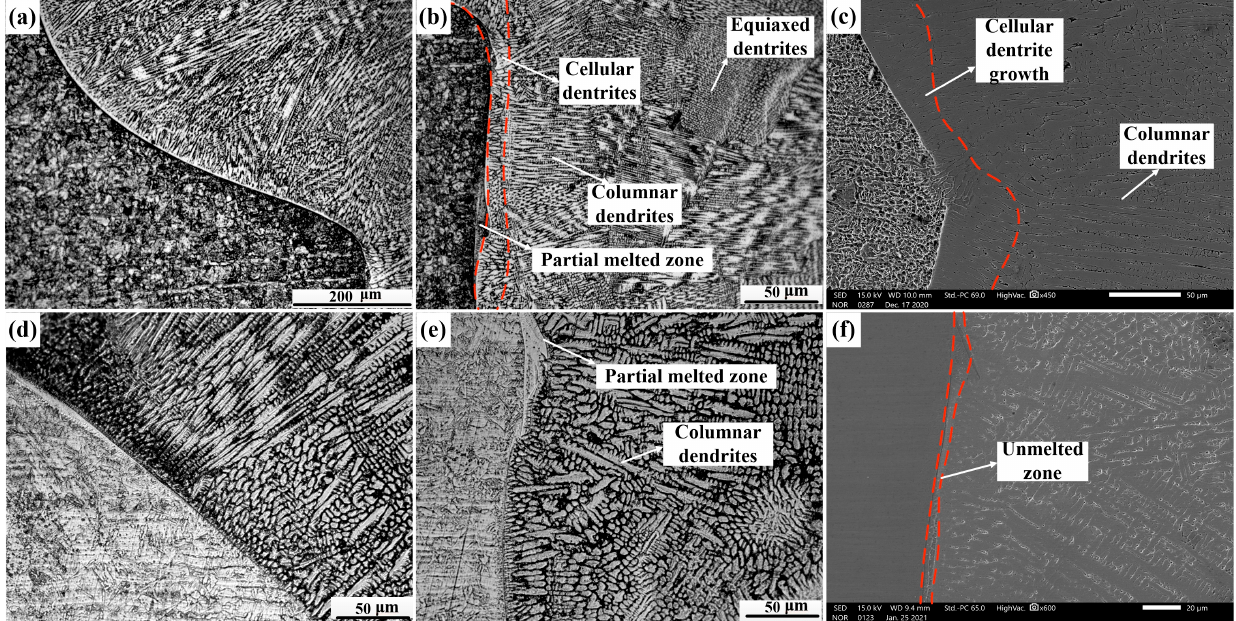
Figure 6. Optical micrographs of the SS/weld interface in joints: ( a ) optical image of S1 in joint 1; ( b ) optical image of S2 in joint 1; ( c ) SEM image of joint 1; ( d ) optical image of S1 in joint 2; ( e ) optical image of S2 in joint 2; ( f ) SEM image of joint 2.